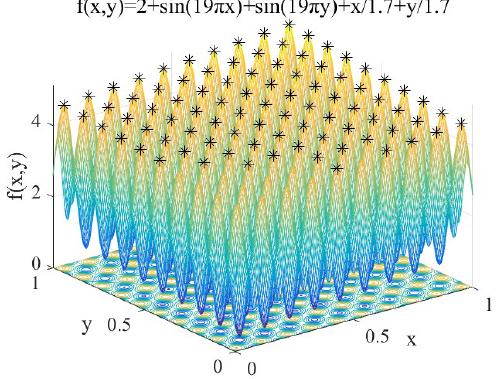
Figure 6. When IAFSA executes AFSA to 90 times.